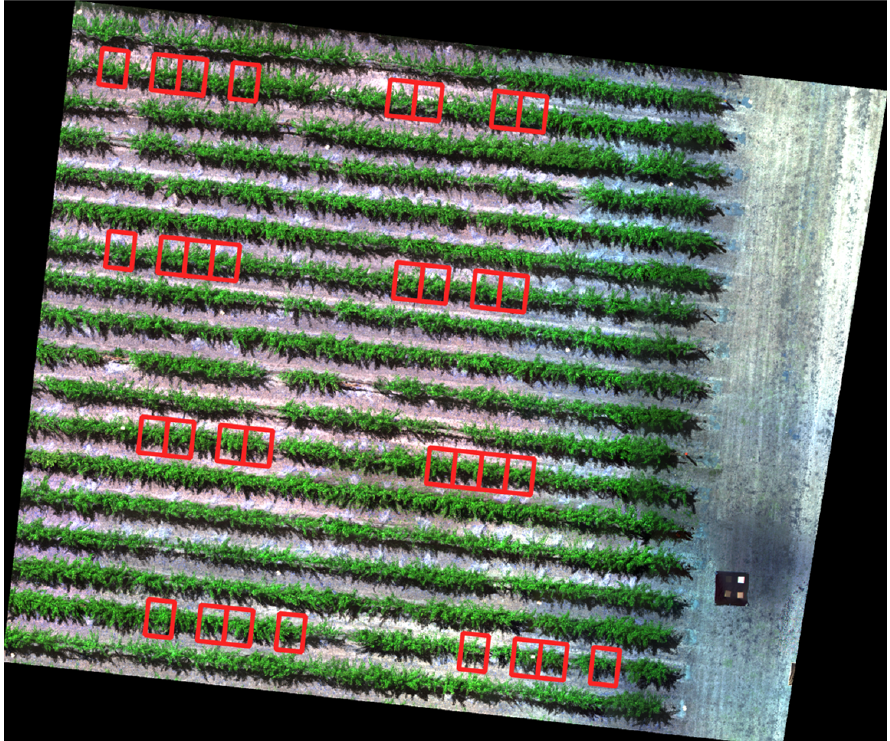
Figure 2. The ground data are sampled from 64 vines (32 on the east and 32 on the west end) of the vineyard (east end shown) per timepoint (EL-31 shown). Highlighted are the measurement vines that were measured throughout the two